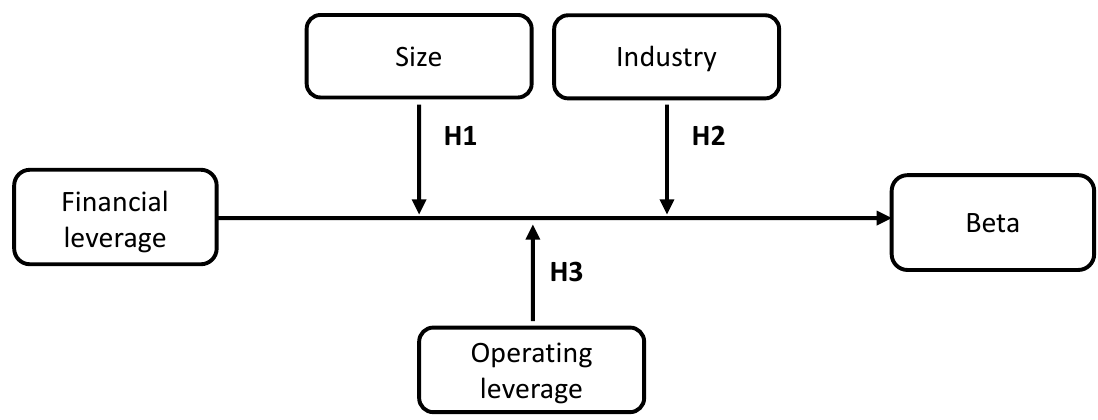
Figure 1. The conceptual framework for hypotheses 1, 2, and